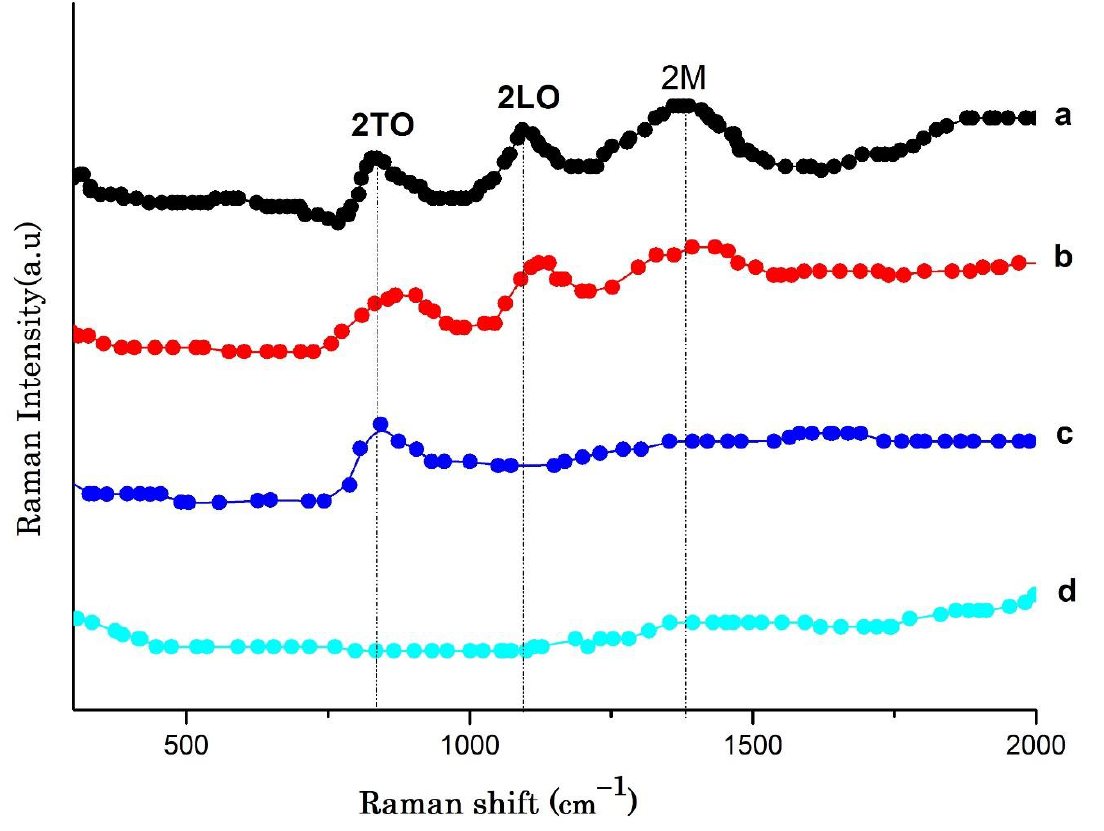
Figure 8. Raman spectra of green synthesized NiO thin films on Cu substrate prepared at